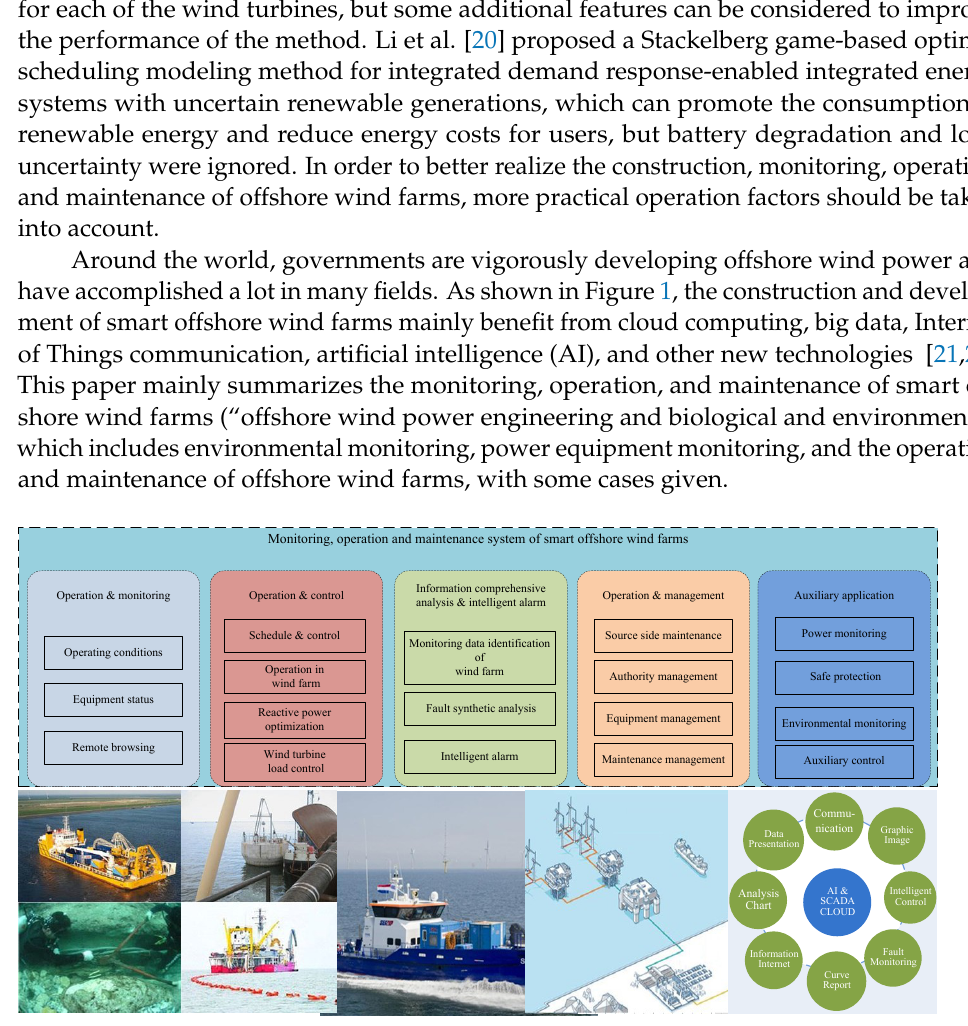
Figure 1. Monitoring, operation, and maintenance system of smart offshore wind